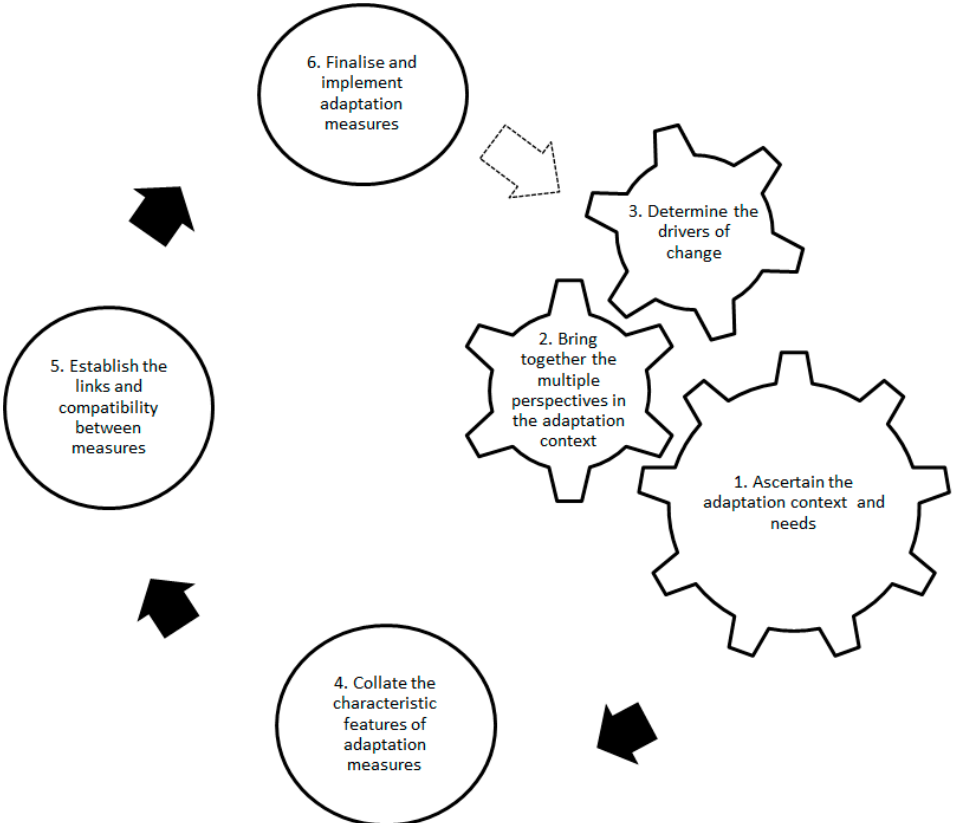
Figure 1. Framework for context specific structuring of climate adaptation responses. The illustration comprises a framework based on multiple perspectives as well singular perspectives. The individual steps (1–6) connected by the dark arrows constitute the comprehensive multiple perspective framework. The white arrow enclosed in black dotted lines represent the feedback and learning from implementation stage to the subsequent adaptation responses that would reduce the gap between planning and implementation.